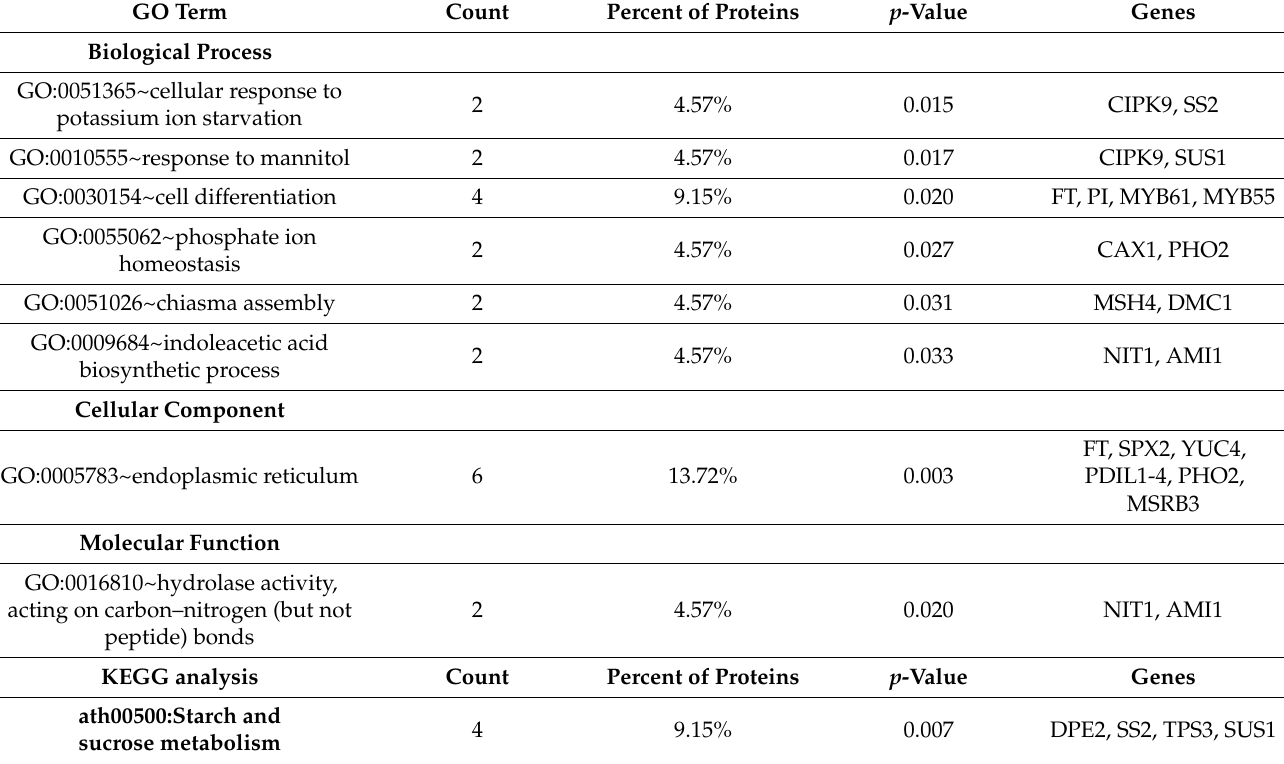
Figure 6. Expression patterns of the most significantly expressed genes across total samples. In the heatmap, the color indicates the expression level of a gene and the column header indicates a sample. Table 2. Functional classification of differentially expressed proteins in rice samples. Proteins are classified into three main categories by GO analysis: biological process, cellular component, and molecular function. Column headers indicate the number of genes in a category, the percentage of a specific category of genes in that category, and the name of genes in that category. KEGG analysis showed one metabolism category. Results were filtered with a p -value < 0.05 as a